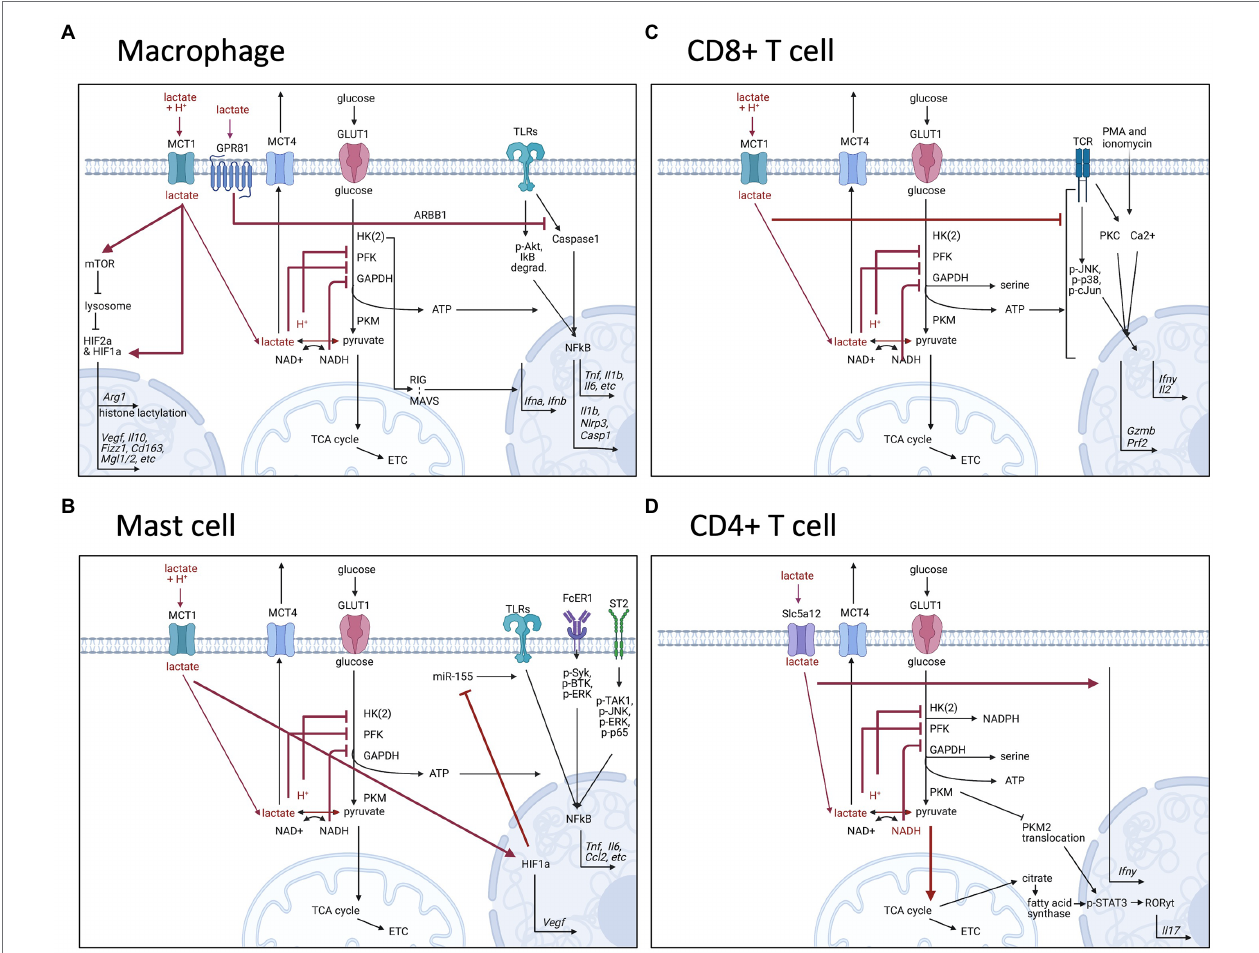
FIGURE 1 | Signaling mechanisms of lactate by cell type. (A) Monocytes and macrophages, (B) Mast cells, (C) CD8 + T cells, and (D) CD4 + T cells. Figure created with